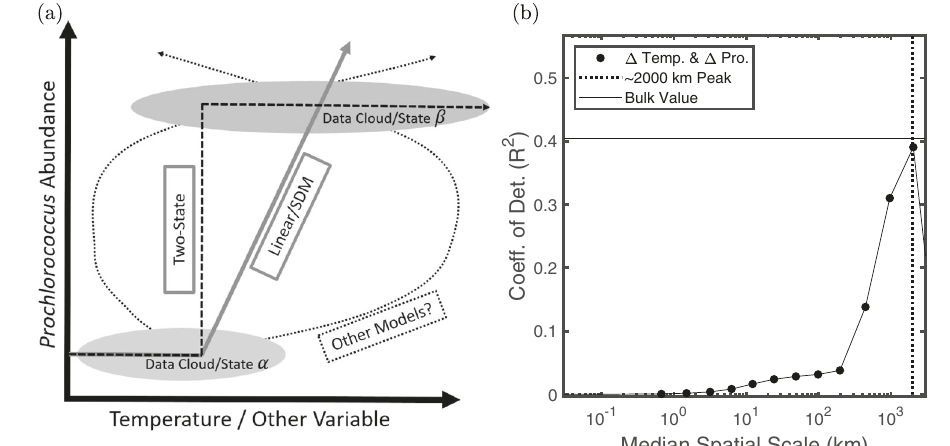
Fig. 5 | Connecting data structure with predictability. a A schematic showing how the spatial structuring of the data can be connected to the bi-modality of the data clouds. Two data clouds ( α and β ) are separated in both parameter and phy- sicalspace.Anin fi nitenumberofmodels,suchasthe fi nelydashedcurves, fi tthese clouds equally well, but their predictions (slopes of curves) are divergent. The two state model is a step function (dashed curve) which predicts no changes with